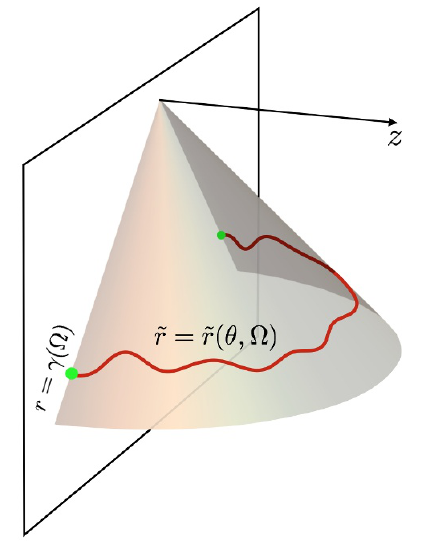
Figure 3 . The extremal HRT surface anchored to the locus r = (cid:13) ((cid:10)) on a boundary null-cone lies on a bulk